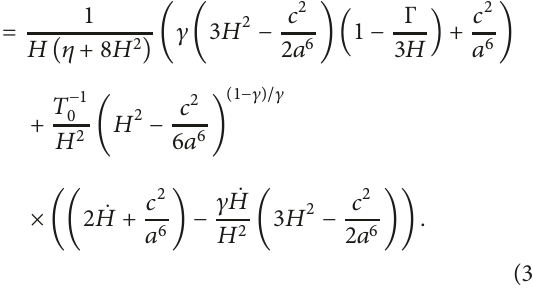
Figure 3: Plot of